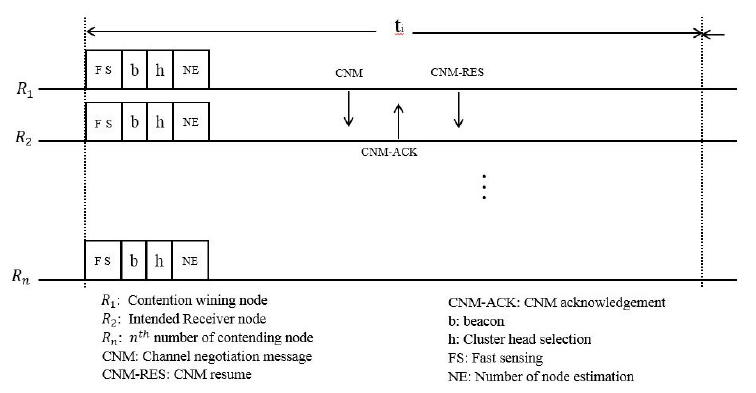
Figure 11 . Channel negotiation in the default slot.